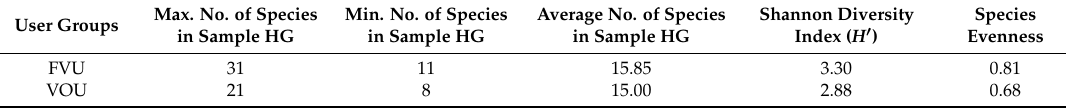
Table 1. Maximum, minimum, and average number of species found in the homegardens (HG) of fruit and vegetable users (FVU) and vegetable-only users